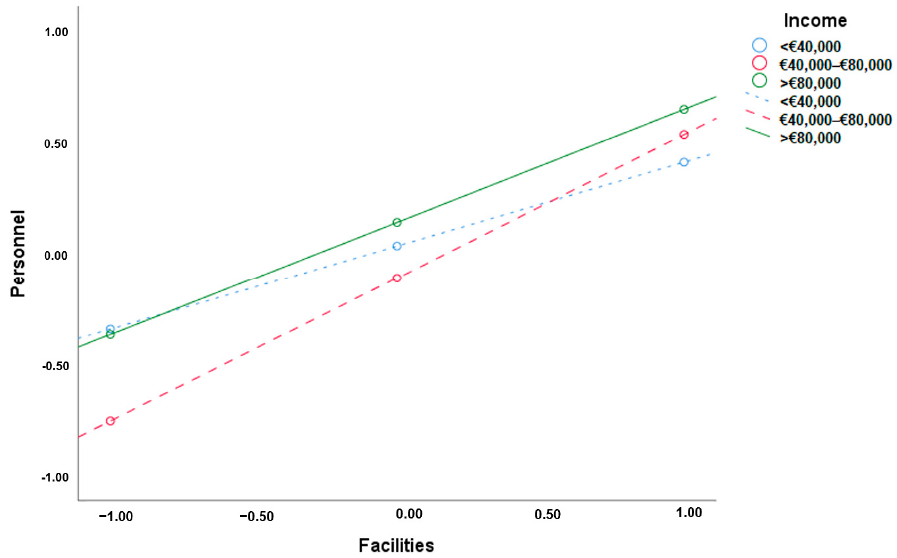
Figure 4. The moderating effect of income on the relationship between facilities and personnel. To test the moderate mediation effect, the indirect conditional effects of facilities on satisfaction across organization and personnel at different income levels were calculated and are presented in Table 8. The unstandardized regression coefficient of the mediating effect of the organization was 0.065 ( p < 0.05) in the lower income range, and it increased significantly to 0.118 ( p < 0.05) in the intermediate income range and remained there in the upper income range. With T1, T2, and T3 representing low-, medium-, and high-income- level families, the difference index between T1 and T2 was 0.053 [0.017, 0.093], which did not include 0, and that between T1 and T3 was 0.020 [ − 0.018, 0.071], which included 0. Therefore, the positive mediating effect of organization was significantly stronger at the intermediate level of income. The same occurred for personnel. The index of the difference between T1 and T2 was 0.067 [0.028, 0.121], which did not include 0, and that between T1 and T3 was 0.032 [ − 0.036, 0.099], which included 0. Again, the positive mediating effect of personnel was significantly stronger at the middle-income level. Therefore, Hypotheses 4a and 4b were supported. Table 8. Moderate mediating effect of family income level.